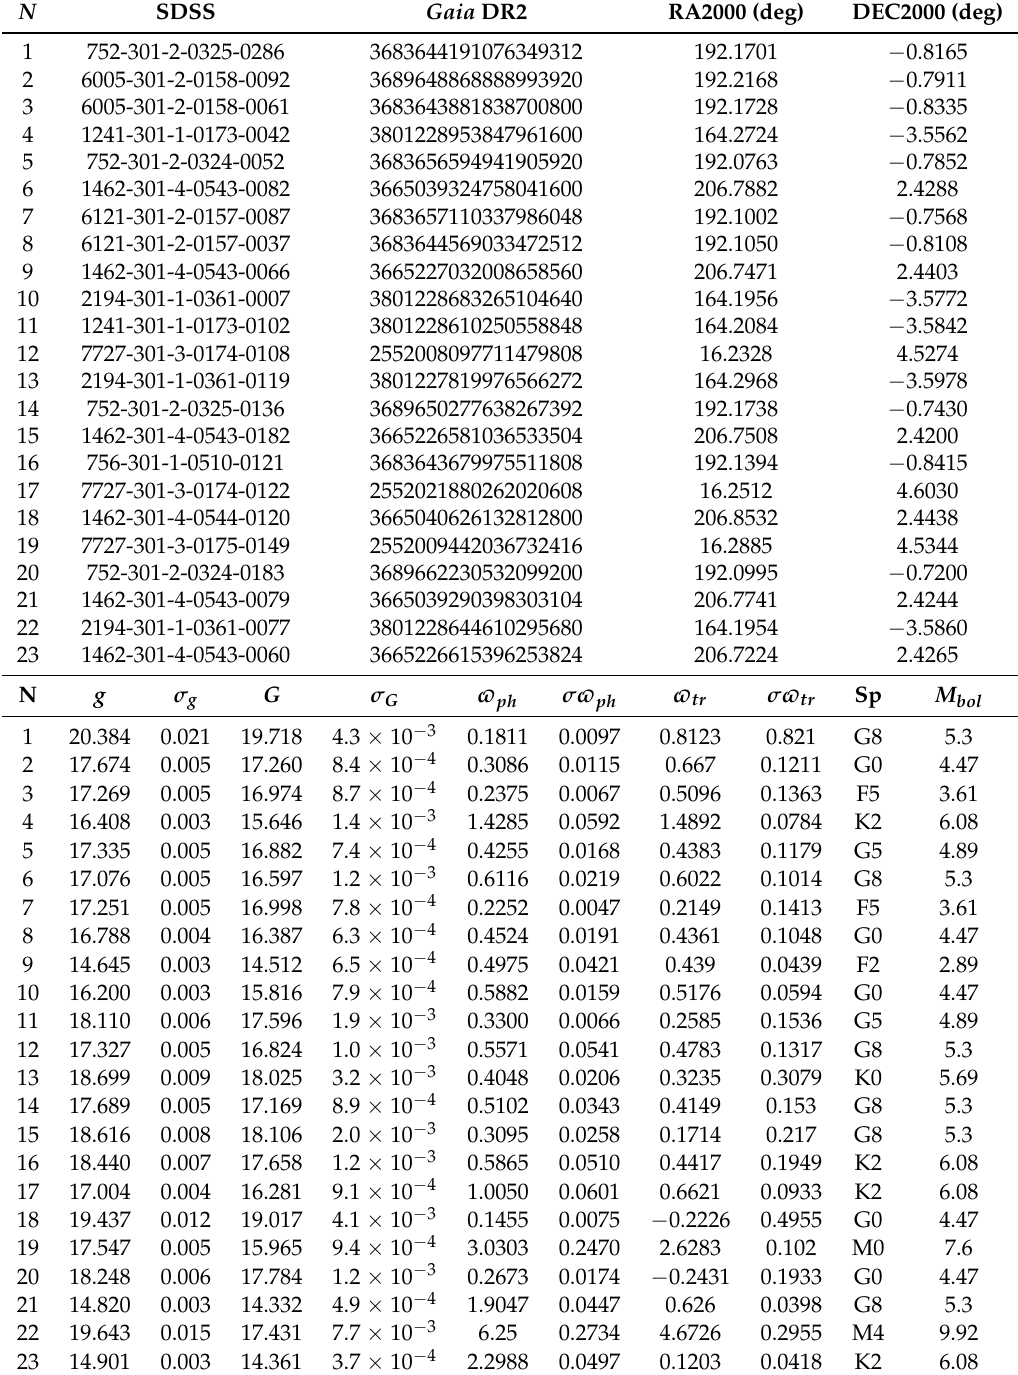
Table 1. Stars used in Paper18 for the A V ( d ) construction. Upper part: running number, SDSS and Gaia identifiers, RA, and DEC (2000) coordinates. Lower part: running number, SDSS ( g ) and Gaia ( G ) photometry with errors, photometric and trigonometric parallax with errors, spectral type estimated in Paper18 and corresponding M bol